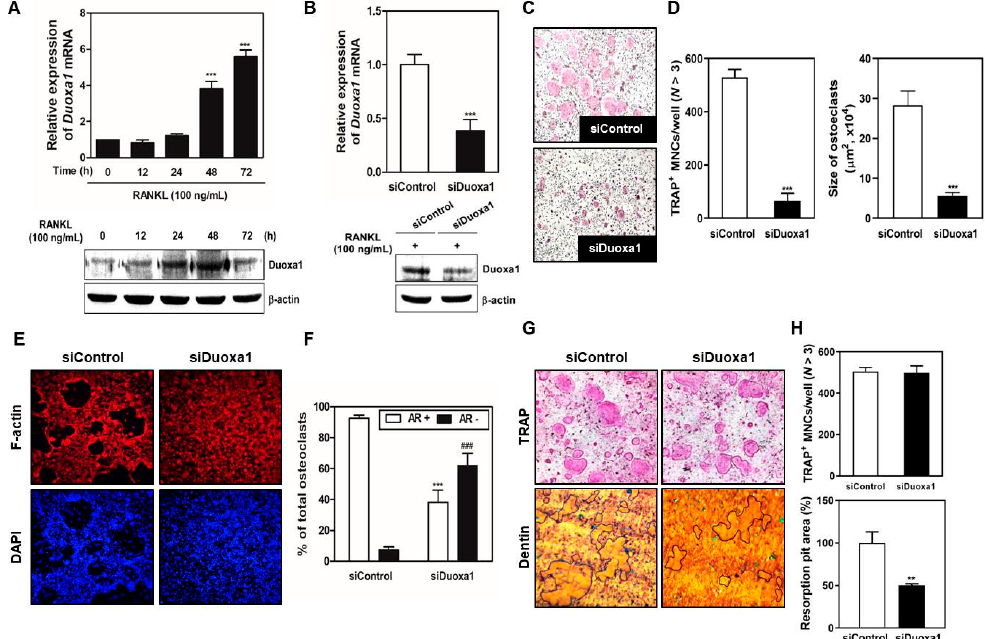
Figure 1. Expression pattern of Duoxa1 during osteoclastogenesis and the e ff ect of Duoxa1 knockdown in RANKL-induced osteoclast di ff erentiation and function. ( A ) BMMs were cultured in the presence of M-CSF (30 ng / mL) and RANKL (100 ng / mL) for the indicated time periods, and the expression of Duoxa1 was analyzed by qRT-PCR and Western blot analysis. The mRNA and protein expression were normalized to GAPDH mRNA and β -actin as an internal control, respectively. Data are presented as the mean ± SD of three independent experiments. *** p < 0.001 versus the control. ( B – F ) BMMs were transfected with siControl or siDuoxa1, and cultured in the presence of M-CSF (30 ng / mL) and RANKL (100 ng / mL) for 3 days. ( B ) Knockdown e ffi ciency of Duoxa1 was confirmed by qRT-PCR and Western blot analysis. ( C ) TRAP-positive cells were determined by TRAP staining ( × 10). ( D ) The number of multinucleated cells (MNCs) with 3 or more nuclei ( left ) and the size of each osteoclast ( µ m 2 ) ( right ) were counting and assessed, respectively. *** p < 0.001 versus the siControl. ( E , F ) Actin ring formation was identified by rhodamine-conjugated phalloidin staining. DAPI staining of the nucleus indicates the control ( × 10). ( F ) The graph was denoted as the quantification of percentage of osteoclasts having actin ring (AR + ) or actin clusters (AR − ). *** p < 0.001 versus AR + of the siControl; ### p < 0.001 versus AR − of the siControl. ( G ) Matured osteoclasts were co-cultured and formed between osteoblast cells and BMCs. The siRNAs transfected into the matured osteoclast cells after plating on dentin slices and cultured for 48 h. The bone resorption regions were highlighted by black borders (×10). ( H ) The number of TRAP-positive MNCs was counted ( upper ) and the resorption areas on dentine slices were quantified with Image J ( lower ). Data are presented as the mean ± SD of three independent experiments. ** p < 0.01 versus the siControl. ns = not significant. 2.2. Knockdown of Duoxa1 Leads to a Decrease in TRAF6-Mediated Signals Interaction between RANK and RANKL leads to the recruitment of TRAF6 to Akt, MAPKs, Src and the NF- κ B pathway. RANK and ITAM-mediated interaction are also involved in synergistic signaling in osteoclast-associated mechanisms, which activate the Btk-PLC γ 2 pathway [21]. In this part, we examined whether Duoxa1 regulates the signaling pathway associated with osteoclasts using siDuoxa1. RANKL-stimulated the expression of TRAF6 and the phosphorylation of Akt, I κ B, Src and MAPKs (p38, ERK, and JNK) were distinctly decreased upon knockdown of Duoxa1 compared to the siControl (Figure 2A,B). Furthermore, increased activation of Btk-PLC γ 2 signaling after RANKL treatment was attenuated by siDuoxa1 compared to siControl (Figure 2C,D). Treatment of RANKL increased the c-Fos and NFATc1 mRNA and protein levels, whereas silencing of Duoxa1 significantly suppressed the RANKL-mediated induction of both transcription factors